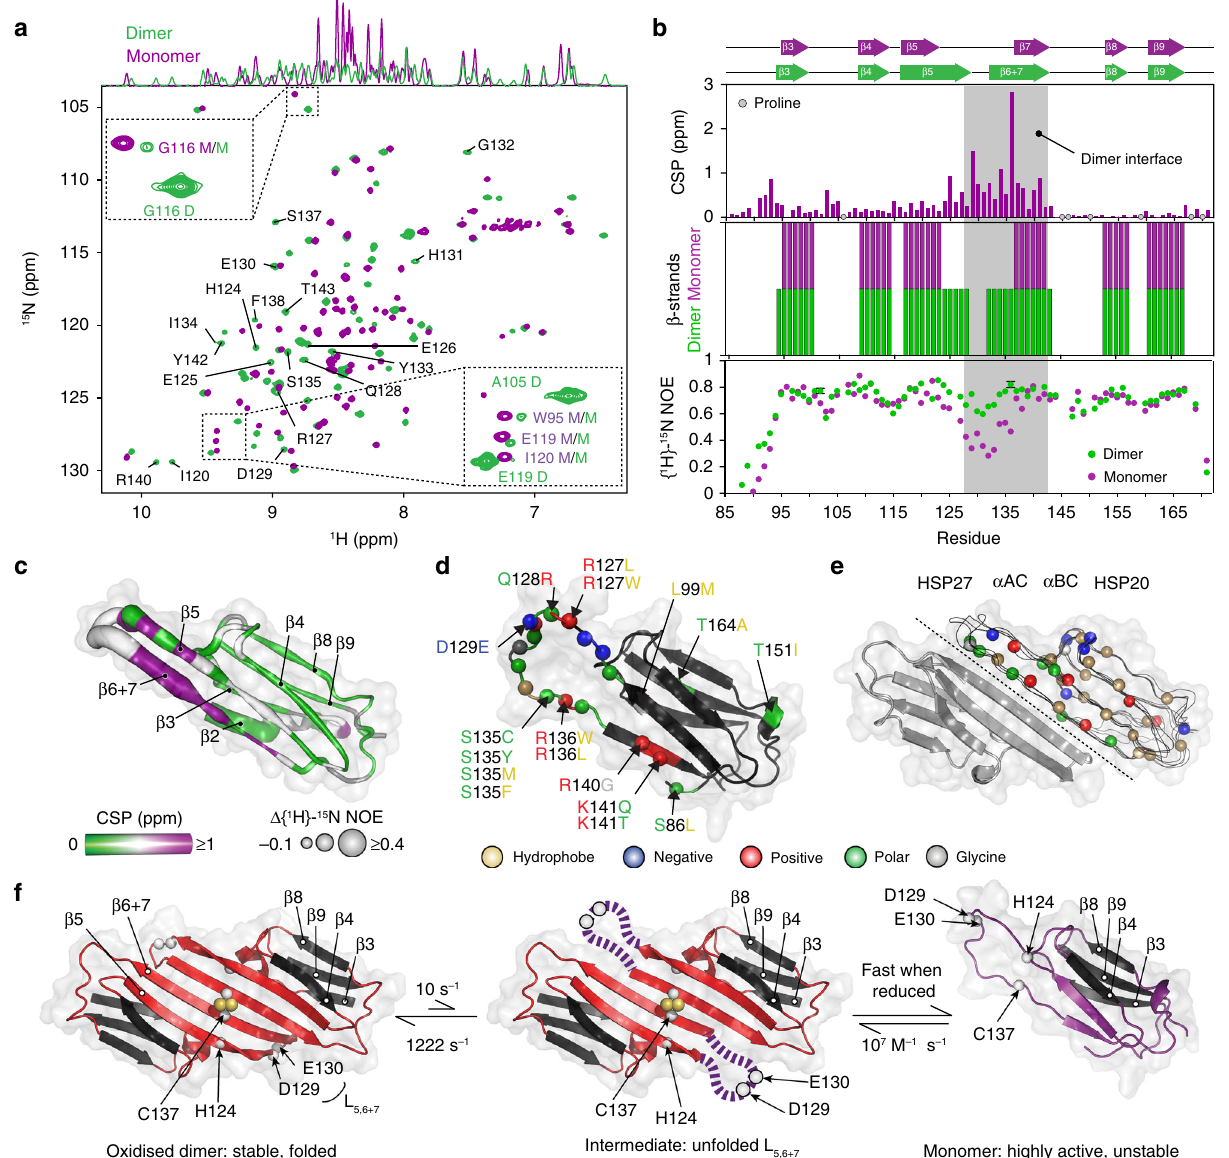
Intermediate: unfolded L 5,6+7 Oxidised dimer: stable, folded Fig. 7 Structural and dynamical characterisation of the cHSP27 monomer. a Overlaid NMR spectra of C137S at 20 μ M and pH 7 (green) where it is predominantly dimeric or pH 4.5 (purple) where it is monomeric. The 1D projection onto the 1 H dimension reveals signi fi cant disorder in the monomer. Insets: minor resonances observable in the pH 7 sample correspond to the directly observed monomer species at pH 4.5. D/M corresponds to dimer/monomer, respectively. b (top) Combined and weighted 1 H, 15 N chemical shift perturbations (CSPs) between the C137S dimer at pH 7 and monomer at pH 4.5, with CSPs computed as described above. (middle) β -strands in the C137S monomer (purple) and dimer (green) as identi fi ed by RCI 57 . (bottom) { 1 H}- 15 N NOEs (hetNOEs) for the C137S dimer and monomer (Supplementary Fig. 9). Error bars are derived from signal-to-noise. c The ACD monomeric fold from PDB 4mjh is shown with the difference (dimer-monomer) in { 1 H}- 15 N NOE values (tube thickness) and magnitude of CSPs (colour). d Inherited mutations that are implicated in the onset of CMT or dHMN disease are indicated in the ACD of HSP27. The mutations cluster to the regions that become solvent exposed upon monomer formation and tend to lower the charge density in the region. e Overlaid dimer structures of human HSP27 (PDB 4mjh), human α B-crystallin (PDB 4m5s), bovine α A-crystallin (PDB 3l1f), and rat HSP20 (PDB 2wj5) are shown in ribbon format for one subunit of each dimer. Their similarity indicates the highly-conserved fold of vertebrate ACDs. The second subunit of HSP27 is shown in cartoon format. Highly conserved residues among human sHSPs (HSPB1-HSPB6) are shown as spheres with the same colour format as d . f Possible hierarchical mechanism of monomer formation. The oxidised, reduced, and C137S forms of cHSP27 exhibit similar dynamics in L 5,6 + 7 and form a disordered loop. In the absence of a disulphide bond, this motion in L 5,6 + 7 propagates, resulting in the eventual unfolding of the β 5 and β 6 + 7 strands in the free monomer. The disulphide bond (C137), L 5,6 + 7 (D129, E130), and H124 are